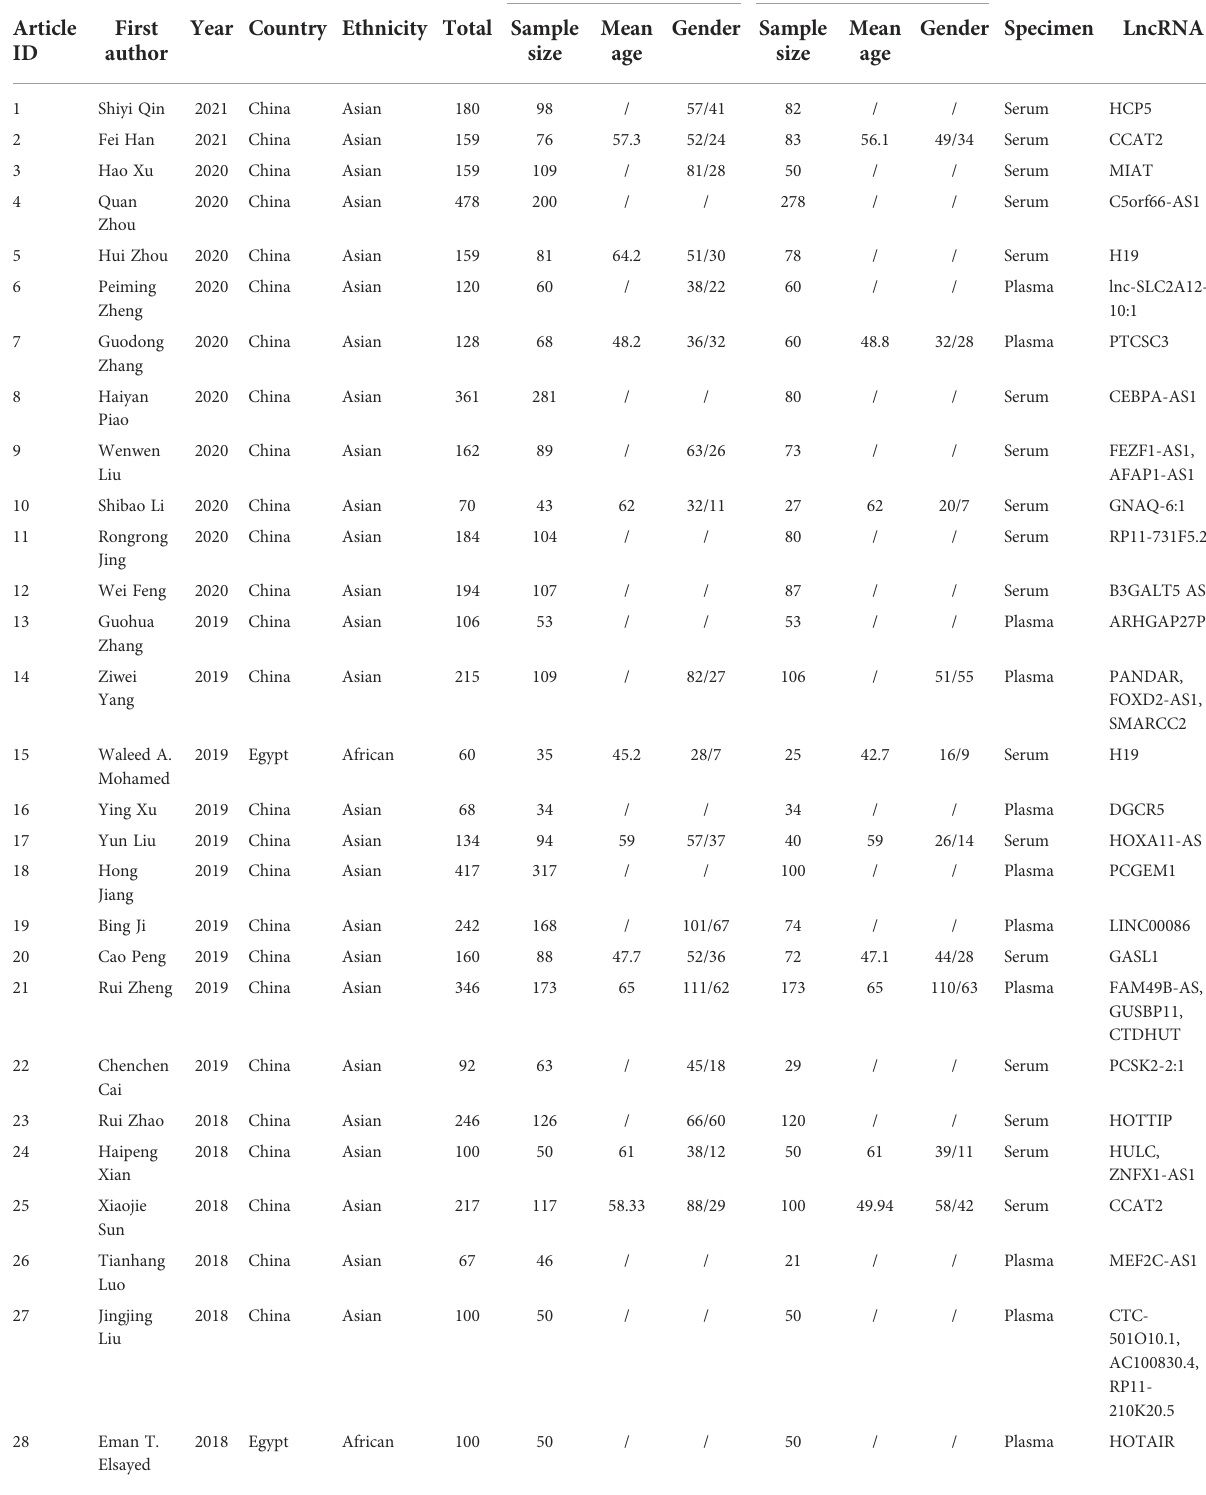
TABLE 1 Characteristics of the studies included in the